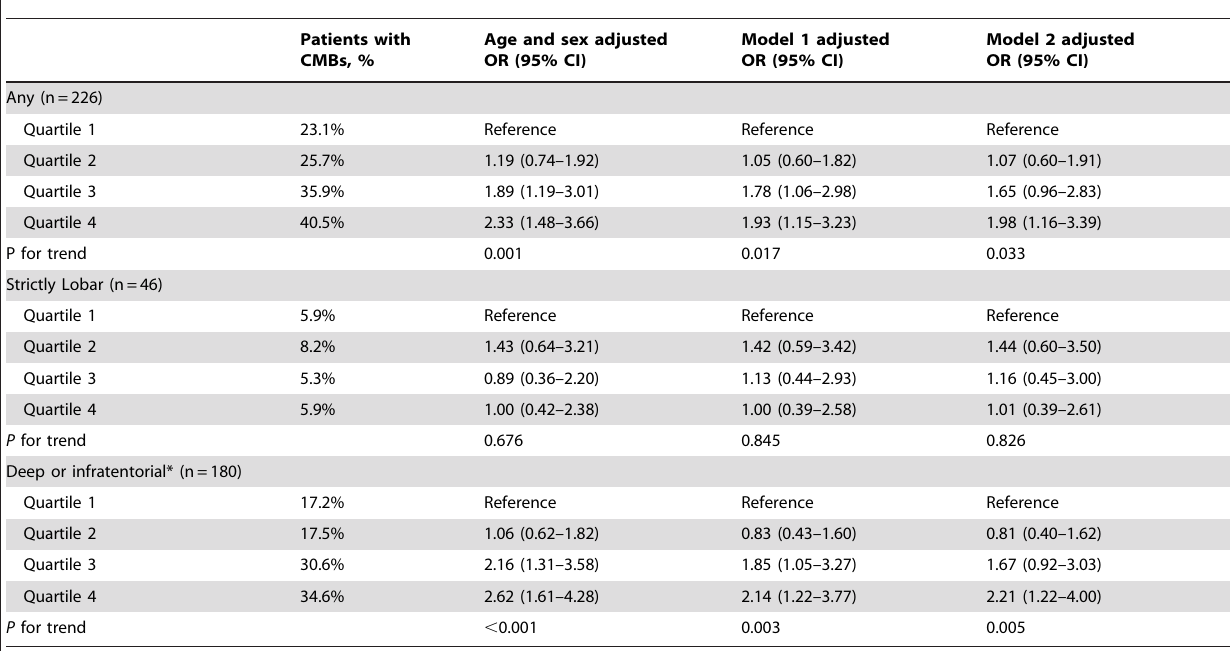
Table 3. Multivariable Logistic Regression Analysis for Presence of Cerebral Microbleeds.